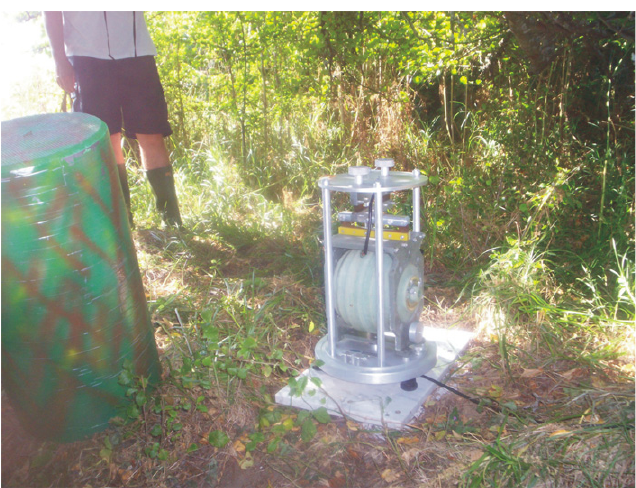
Figure 1. The DIDD device on levelled marble plate in Krbavsko Polje sta- tion. The green cylinder on the the left is the instrument case which protects the instrument against humidity and improves the temperature stability.